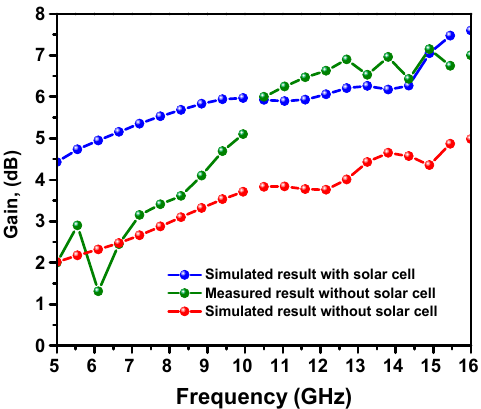
Figure 5. Simulated and measured realized gain of the proposed CPW-fed monopole antenna with and without the presence of organic solar cell.